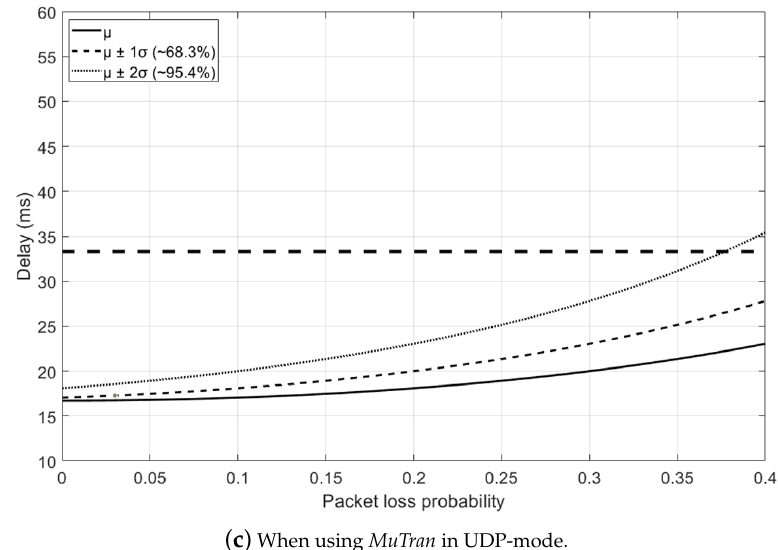
Figure 8. The analytic delay results in the practical